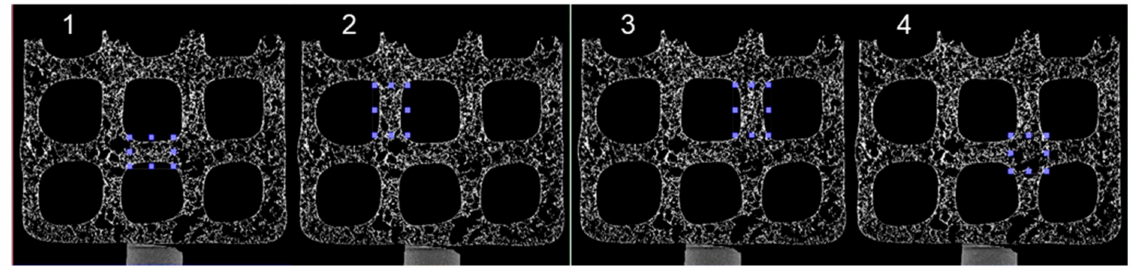
Figure 1. Parts of samples chosen for 3D pore morphology analysis by X-ray micro tomography (marked with blue in images